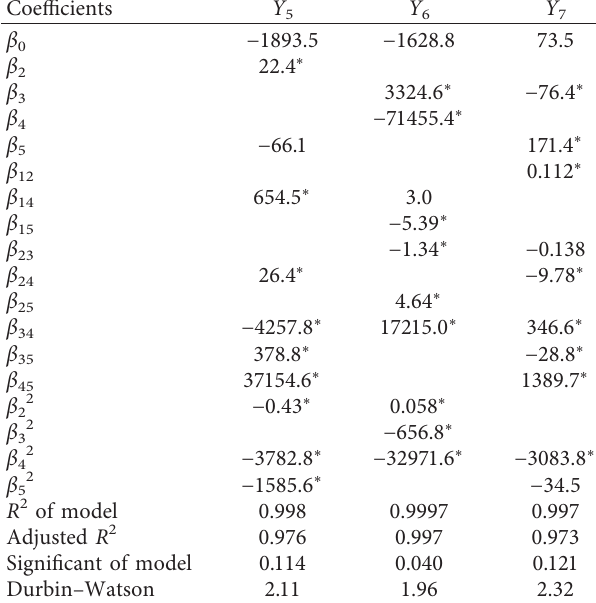
Table 4: Significance of regression coefficients and regression equations for antioxidant activities of lactic acid bacteria fermented wheat germ